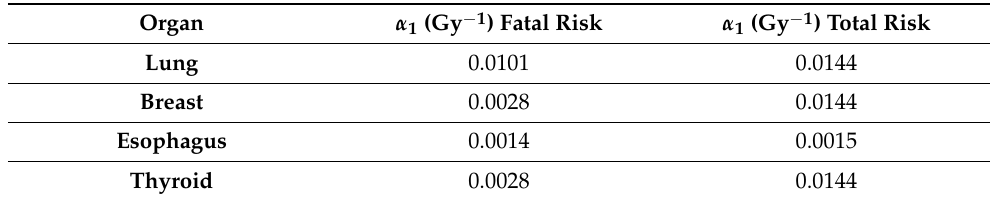
Table 2. Organ specific incidence I org